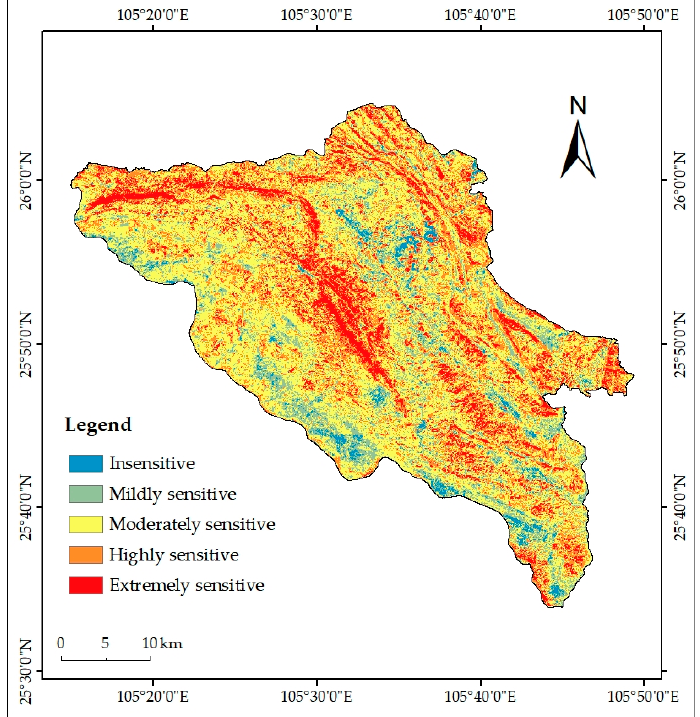
Figure 4. Ecological sensitivity distribution map of Guanling County.